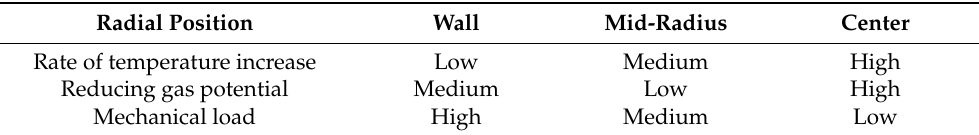
Table 5. Approximate conditions at different radial positions in the blast furnace in studies by Sterneland and Lahiri [38,39]. Radial Position Wall Mid-Radius Center Rate of temperature increase Low Medium High Reducing gas potential Medium Low High Mechanical load High Medium